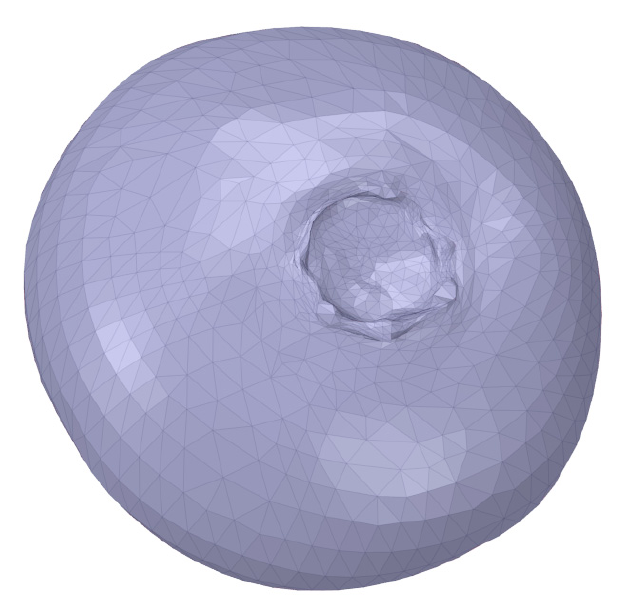
Figure 1. An example of a shape of a particle in Rocky DEM (Discrete Element Method).